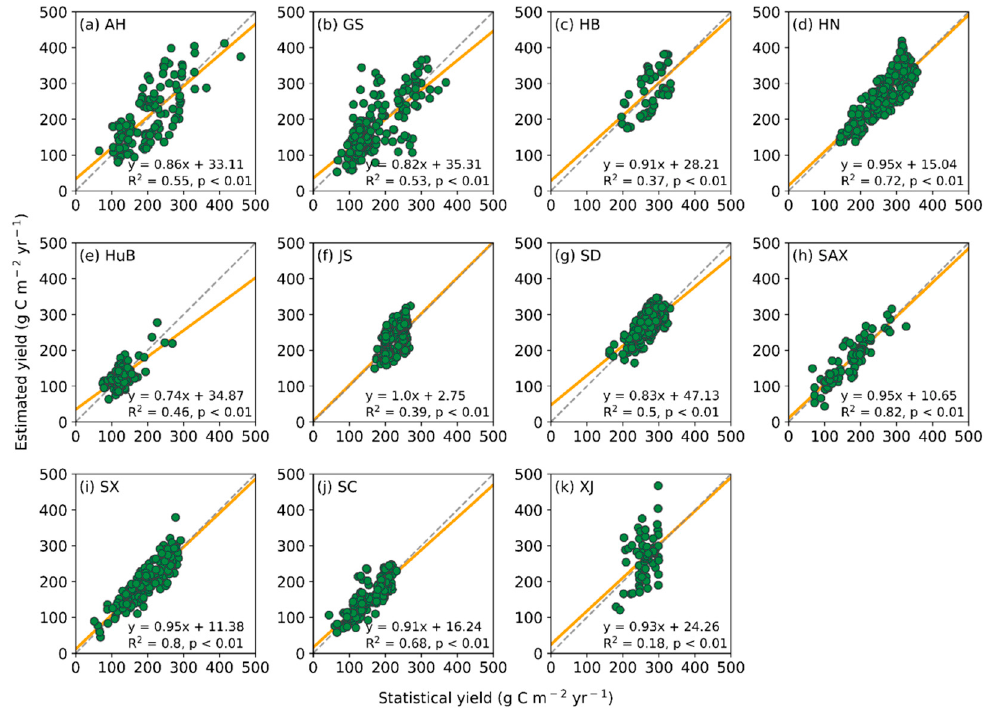
Figure 6. Statistical and estimated yield at county scale during 2016–2018. The green dots represent the counties of the corresponding province. The yellow solid lines are the regression lines and the grey short-dashed lines are the 1:1 lines. ( a – k ) show the correlation between statistical and estimated yield at county scale during 2016-2018 in AH, GS, HB, HN, HuB, JS, SD, SAX, SX, SC and XJ provinces, respectively.